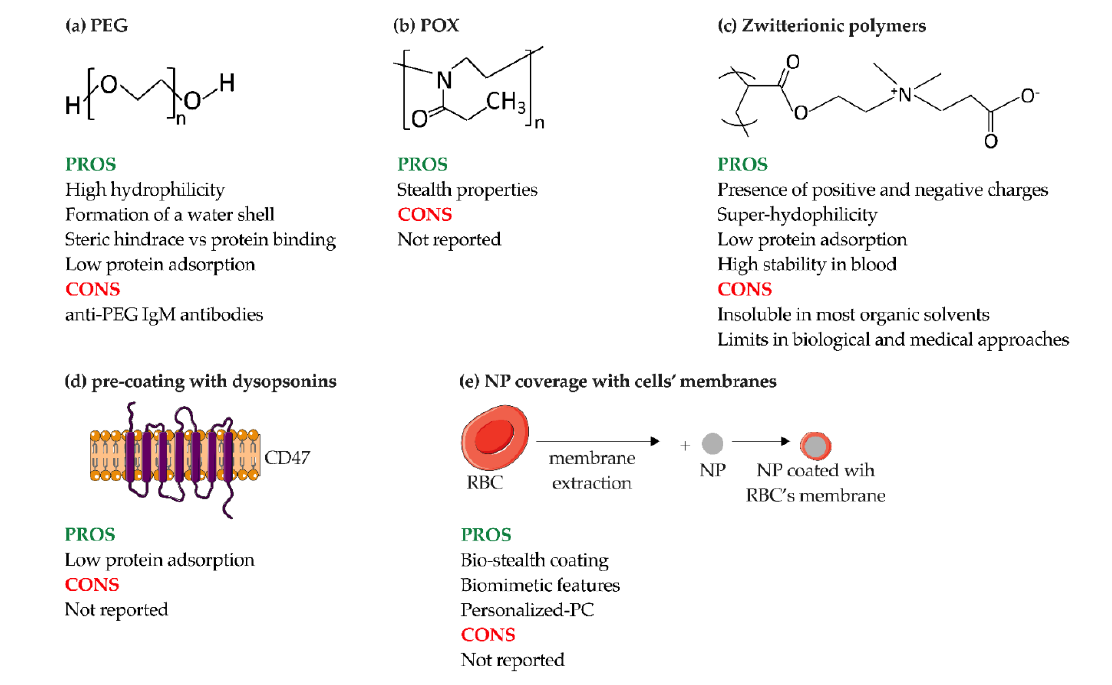
Figure 8. Methods to avoid immune system engulfment of NPs. ( a ) PEG; ( b ) POx; ( c ) zwitterionic polymers; ( d ) pre-coating of NPs with dysopsonins; and ( e ) coverage of NPs with membranes derived from cells. POx: poly(2-Oxazoline); RBC: red blood cell. The figure was partly generated using